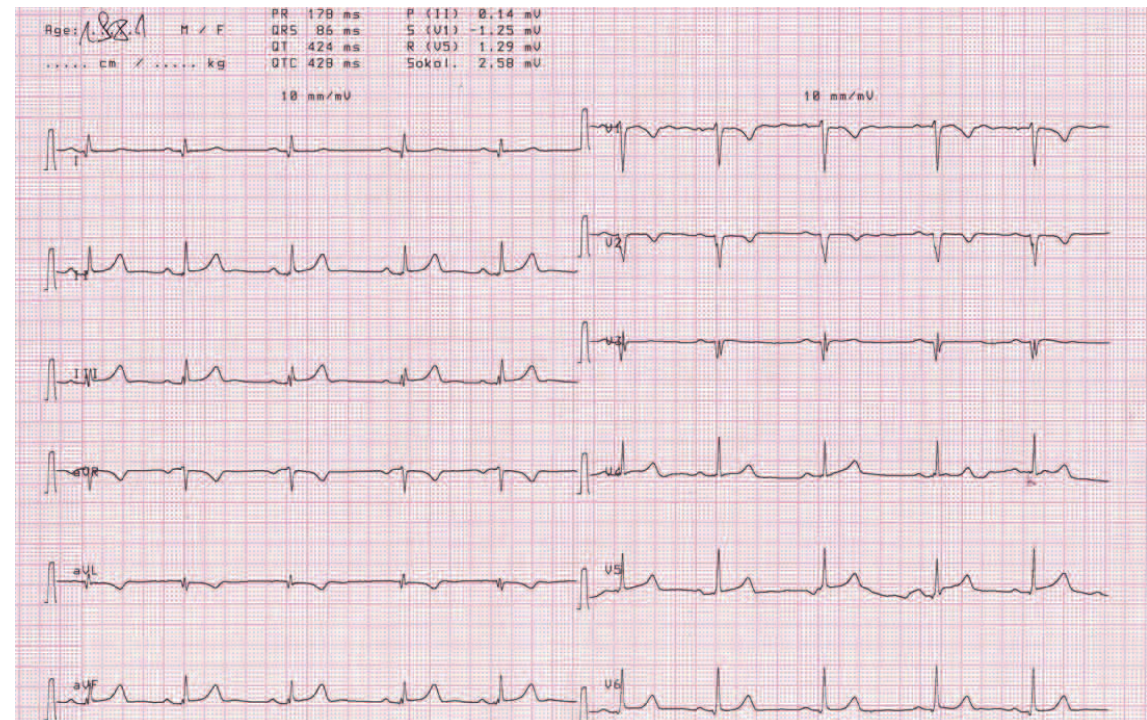
Figure 8. ECG showed regression of the ST elevation of the anterolateral